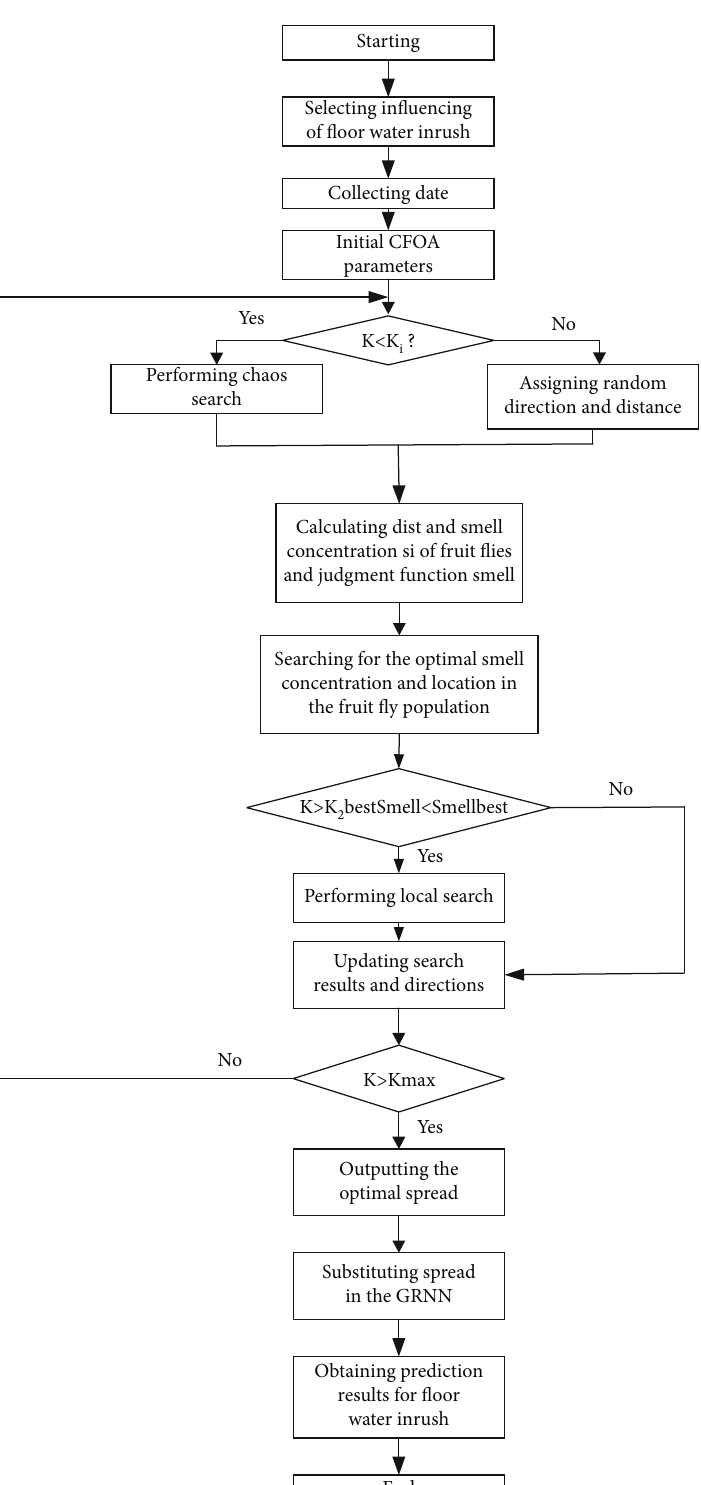
Figure 2: Flowchart of the CFOA – GRNN prediction